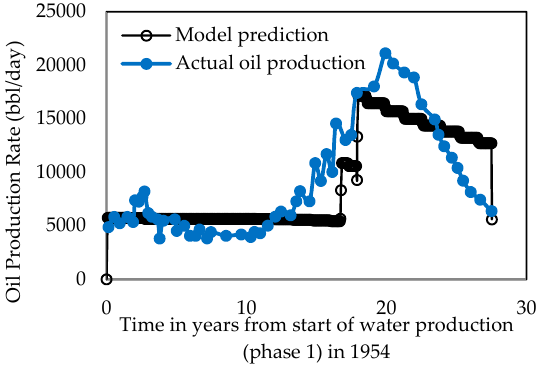
Figure 6. Comparison of predicted and actual oil production rates.